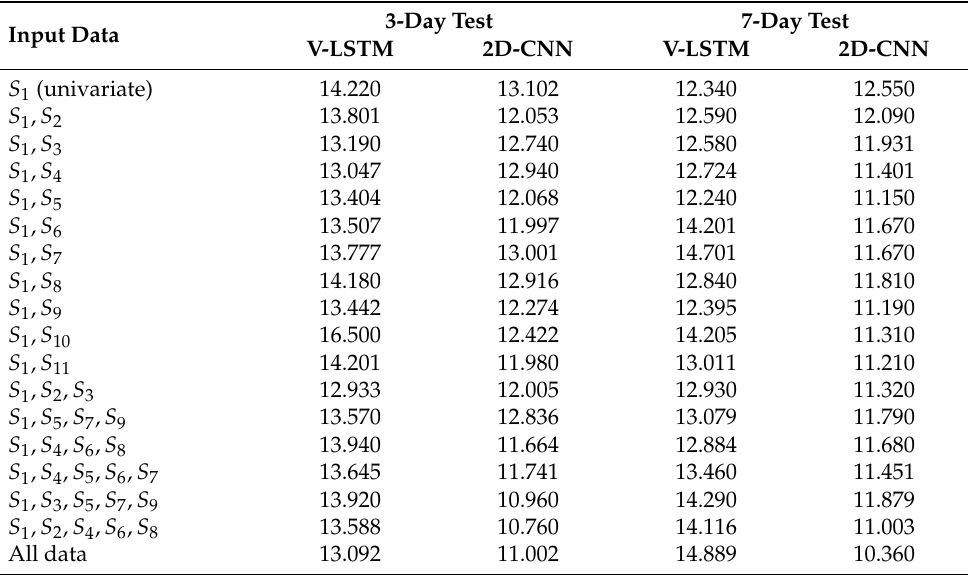
Table 8. Average RMSE for October 2018 tests, carried out by using V-LSTM and 2D-CNN models and different combinations of time